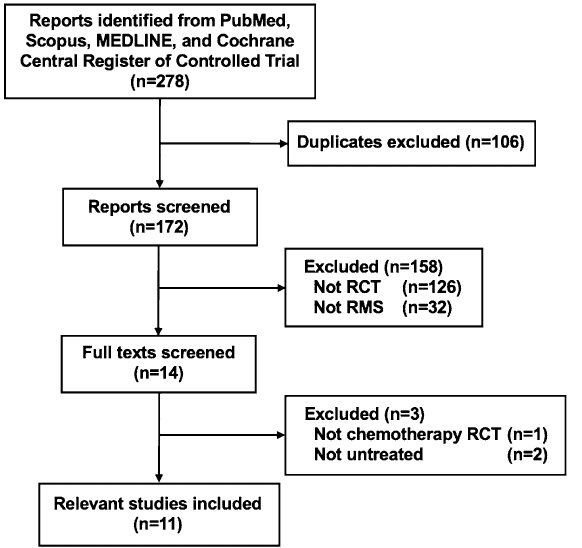
Figure 1. PRISMA flow diagram. Abbreviations: RCT, randomized controlled trial; RMS,